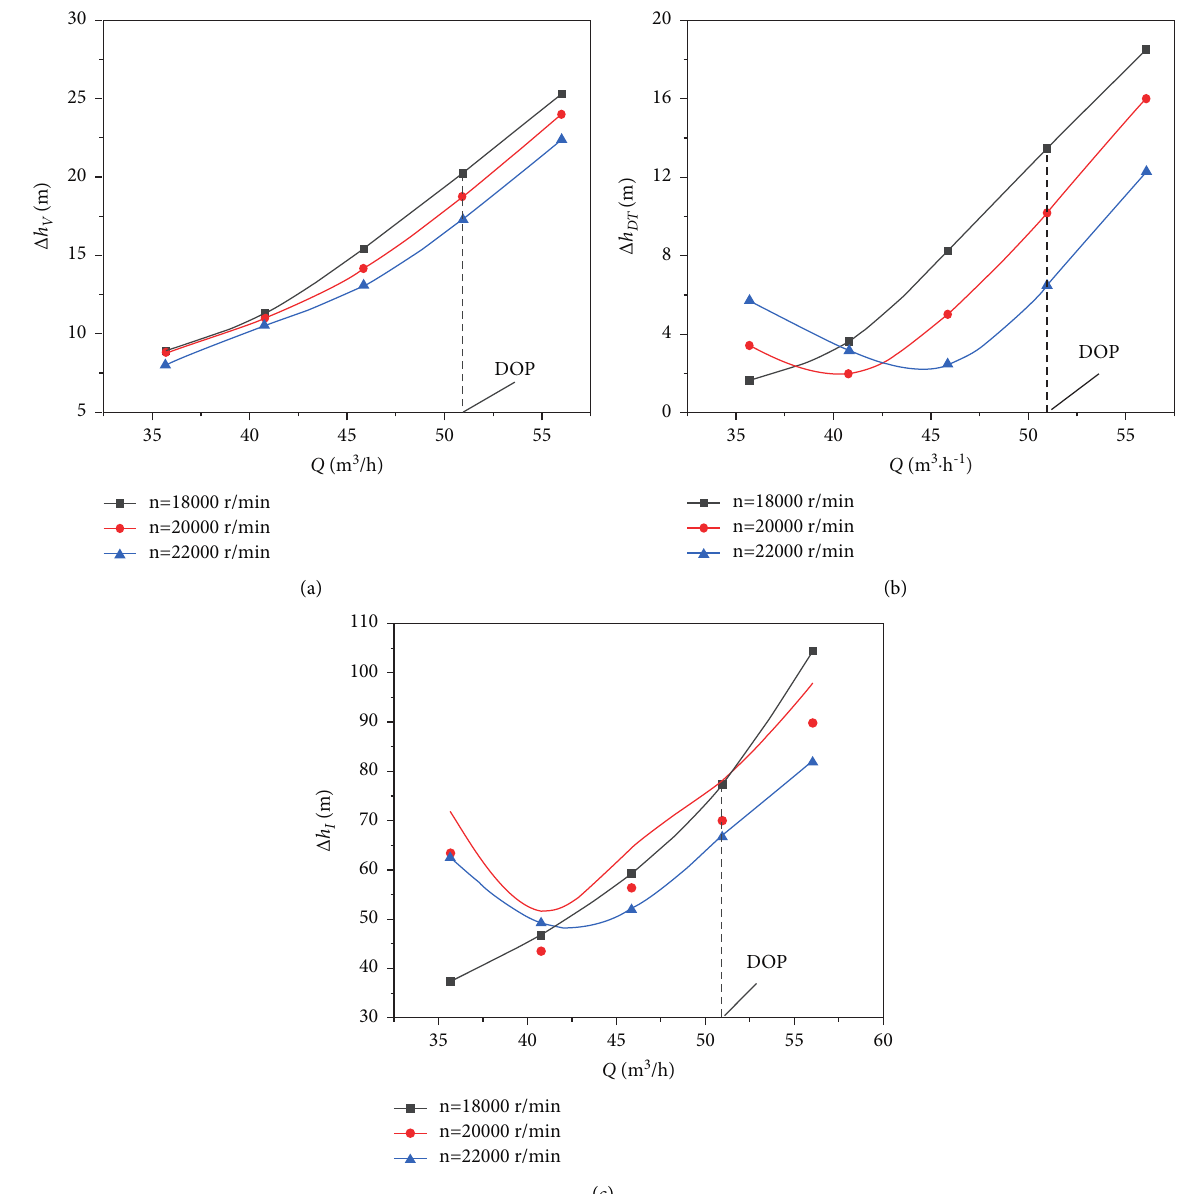
Figure 10: Loss distribution of turbine components. (a) Volute loss. (b) Draft tube loss. (c) Impeller